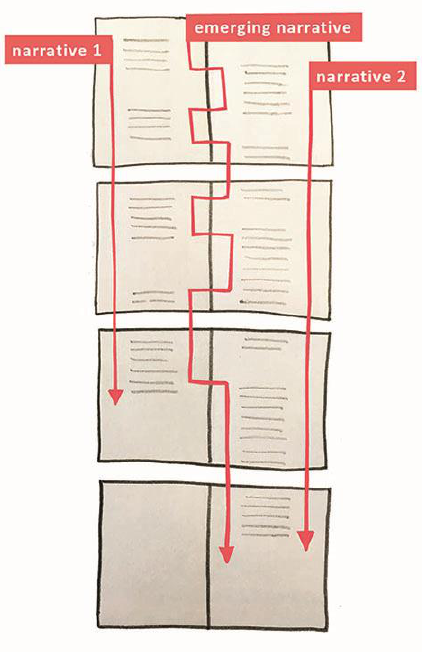
Figure 5 : Structure of the emerging narrative/s (Source: Perold-Bull, 2018) In structuring the text, we have made use of space, shape and colour as visual cues that can assist in directing (but not predetermining) the readers’ attention throughout the rea ding experience (see Figure